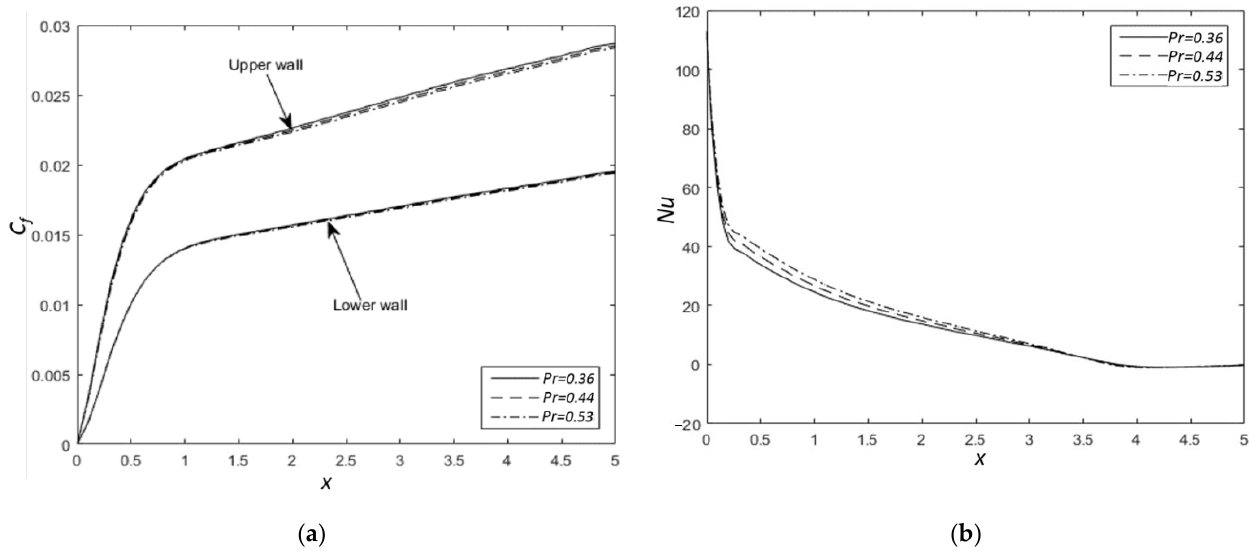
Figure 10. Wall Skin Coefficient and Nusselt number under different Prandtl numbers: ( a ) Skin friction coefficient; ( b ) Nusselt number.